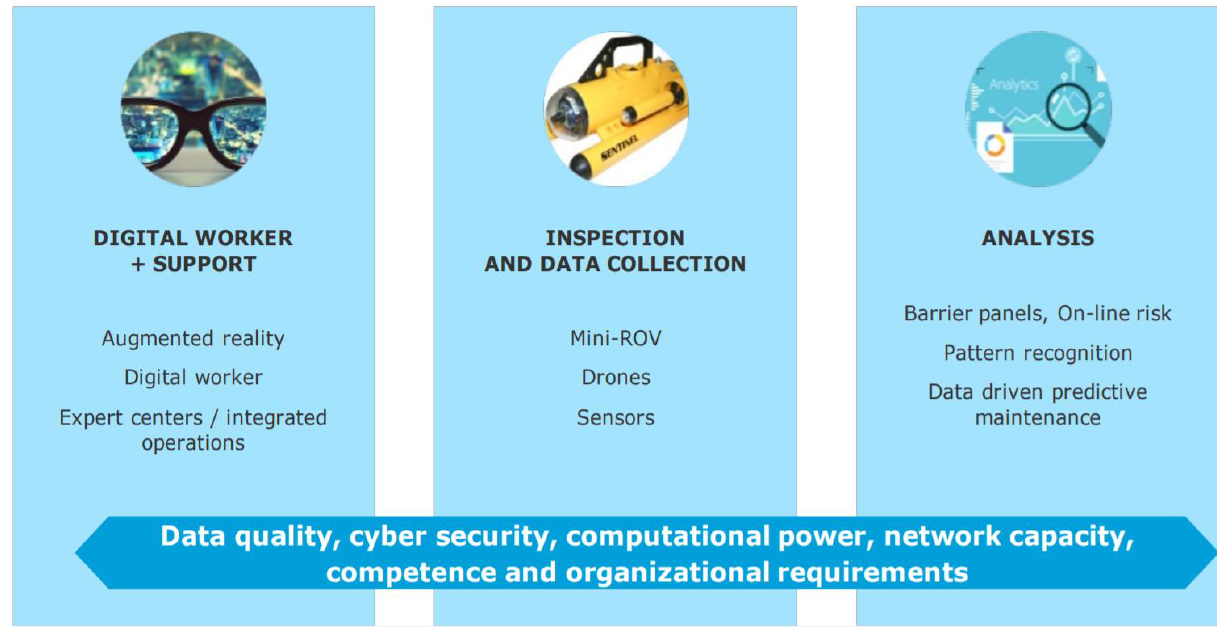
Figure 5. The key enablers for digitalization in subsea integrity management [3].